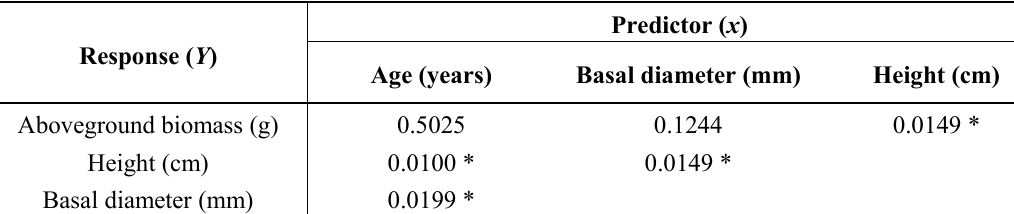
Table 2. Significance levels ( p -values) for the non-parametric analyses of covariance (ANCOVA) testing for a difference in the relationships for the two environments between age, basal diameter or height, as predictor variables and aboveground biomass, height or basal diameter as response variables.